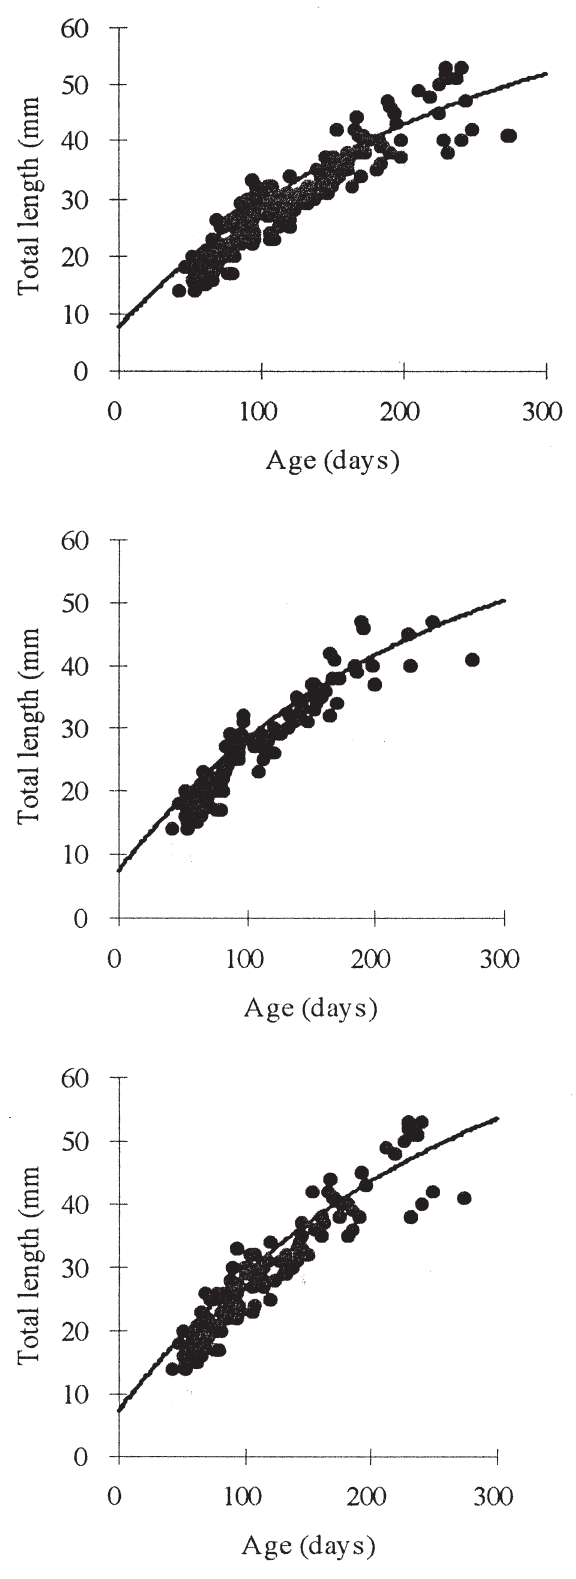
IG . 4. – Von Bertalanffy growth curves for whole population (above), females (+ indeterminates) (middle), and males (+ indeter- minates) (below) of A. minuta from the Adriatic